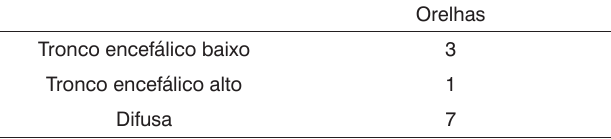
Tabela 6. Comparação do local de alteração no tronco encefálico.